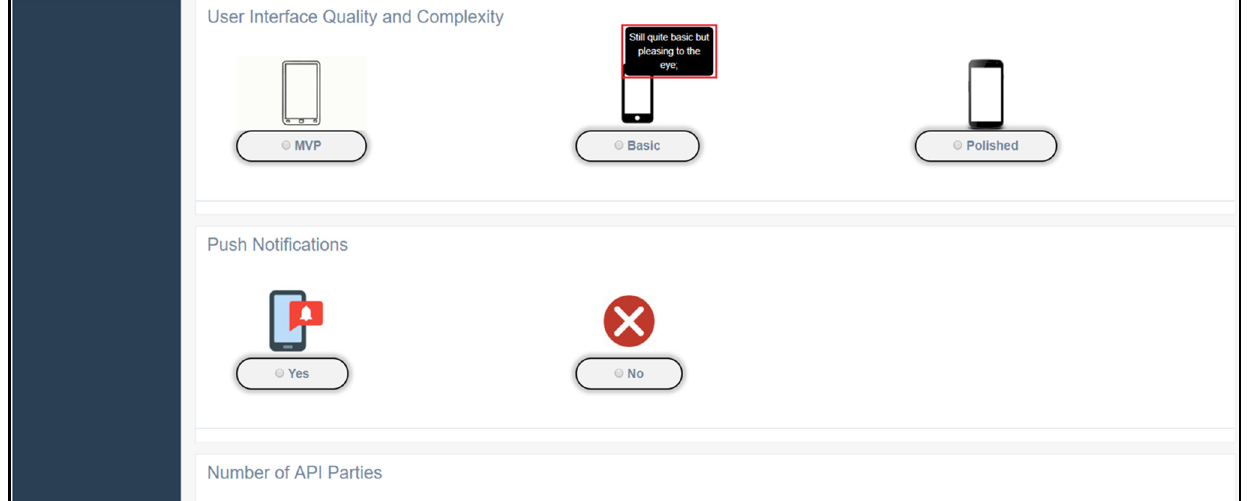
Figure 4. User interface for tooltip function.